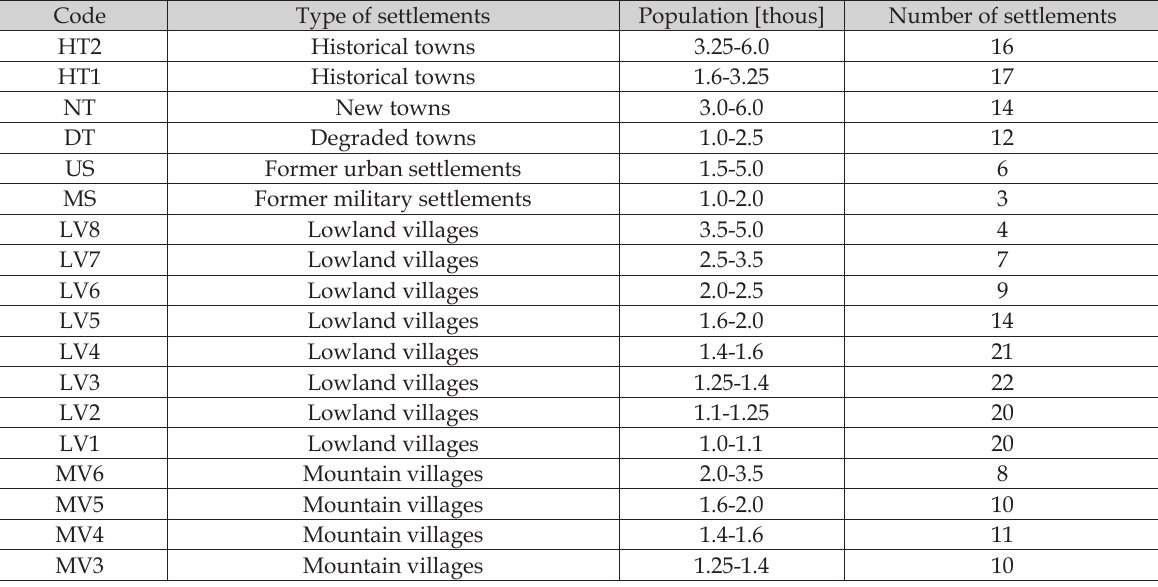
Table 2. Typology of small towns and big villages in the south-west region of Poland.